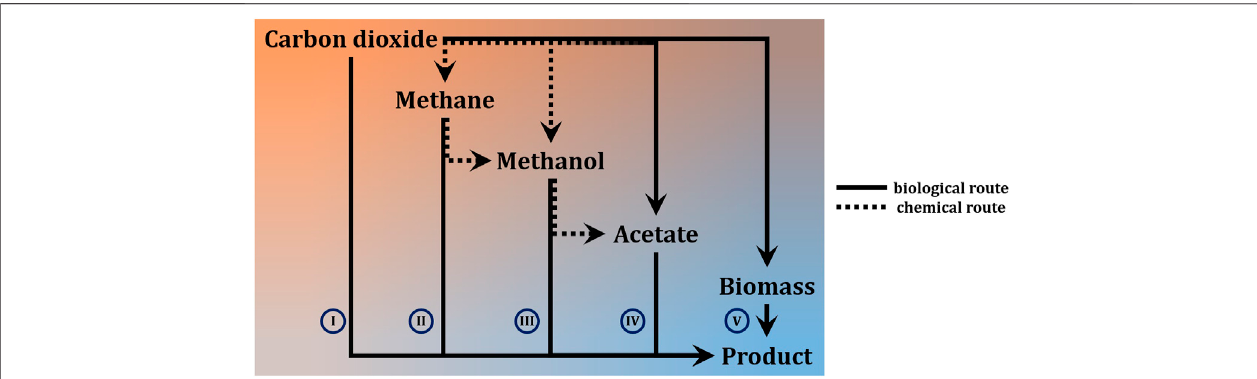
FIGURE 1 | High-level differentiation of approaches for conversion of carbon dioxide from Martian atmosphere into carbon-based products via microbial ISRU. Solid lines are bio-based processes, dashed arrows indicate involvement of catalytic (chemical) steps. The fading dashed line indicates a combined chemical-biological approach,ratherthanalternatives(I)single-stepprocessfrominorganiccarbondirectlytotargetcompound(II) — (IV)processesthatrelyonsigni fi cantauxiliaryinput,(e.g. chemical conversion of CO 2 to CH 4 or bioconversion of CO 2 to CH 3 COOH) (V) two-step processes via intermediate with broad bio-availability.